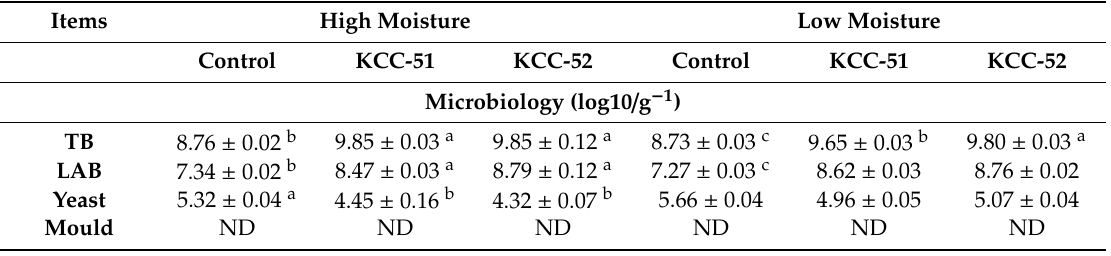
Table 3. Microbial populations of low and high moistures silages of triticale in non-inoculated and inoculated (KCC-51 and KCC-52) silages of triticale at high and low moistures. Items High